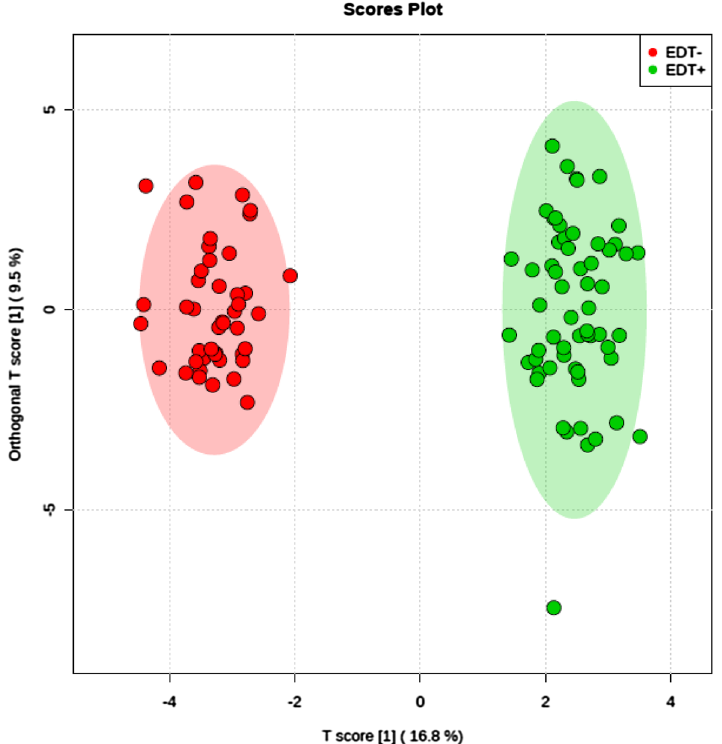
Figure 1. Endometriosis Score Plot. Orthogonal partial least squares discriminant analysis (OPLS-DA) score plot model indicating separation between non-pregnant women (red) and pregnant women (green), both groups diagnosed with endometriosis displayed clustering of data on positive ion mode. Figure generated using MetaboAnalyst (www. metab oanal yst. com). The mass spectrometry analysis was performed in quintuplicate for each sample, therefore each patient is represented by 5 (five)